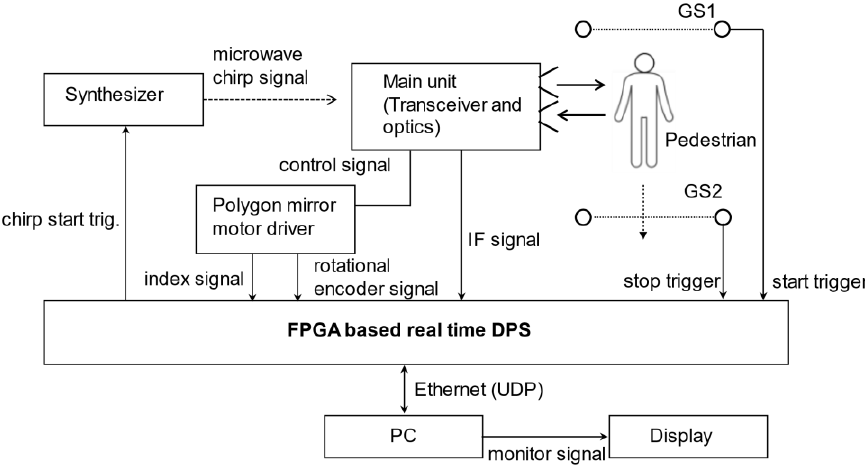
Figure 7. Block diagram of walk-through body scanner.